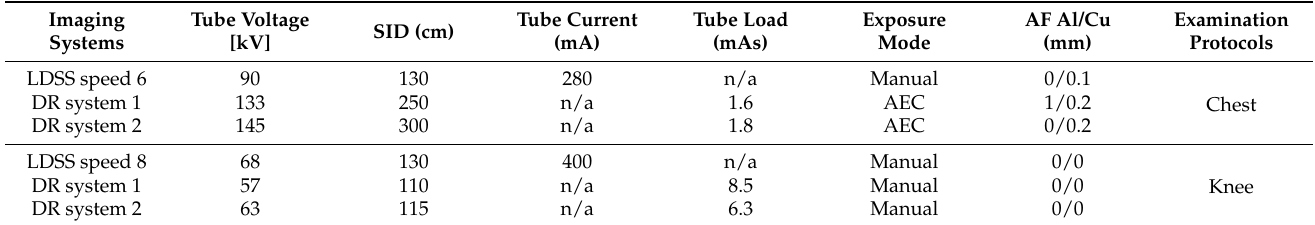
Table 2. Exposure settings in chest and knee examinations for all imaging systems.